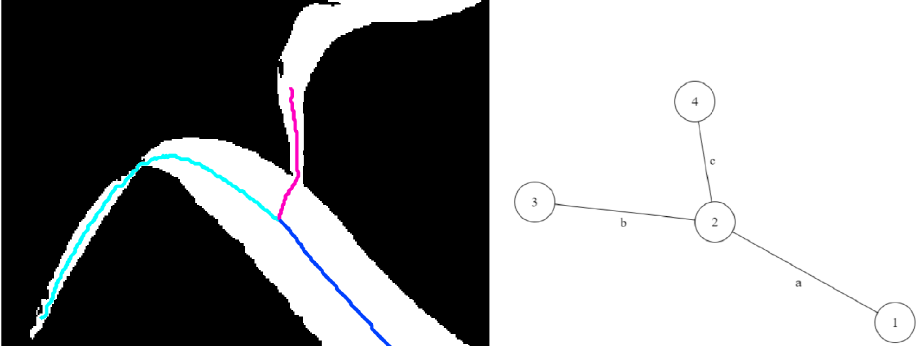
Figure 11. Illustration of tip-contact: ( left ) skeleton; ( right ) skeleton-graph representation.